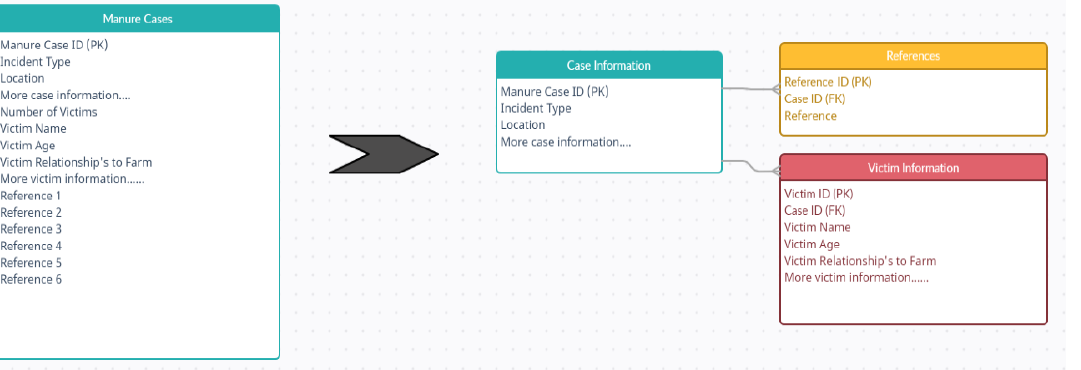
Figure 6. Subset of data normalization.